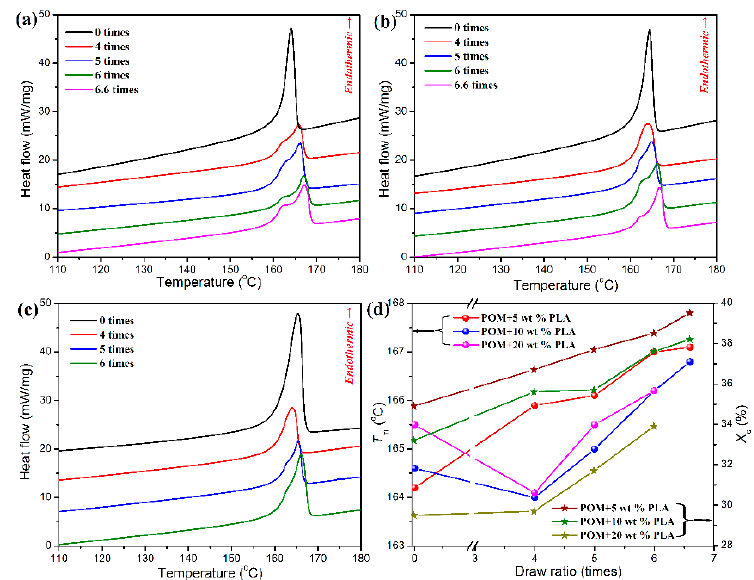
Figure 7. DSC thermograms of POM/PLLA bicomponent fibers containing ( a ) 5, ( b ) 10, and ( c ) 20 wt % PLLA at different draw ratios; ( d ) melting temperatures and degree of crystallinity of POM/PLLA bicomponent fibers at different draw rations.